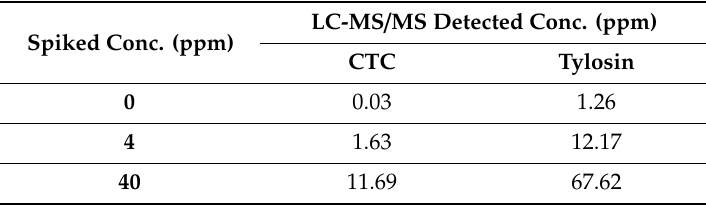
Table 10. Concentrations of measured calibration standards.